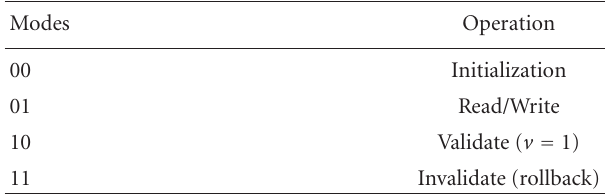
Table 1: SCHJ operating